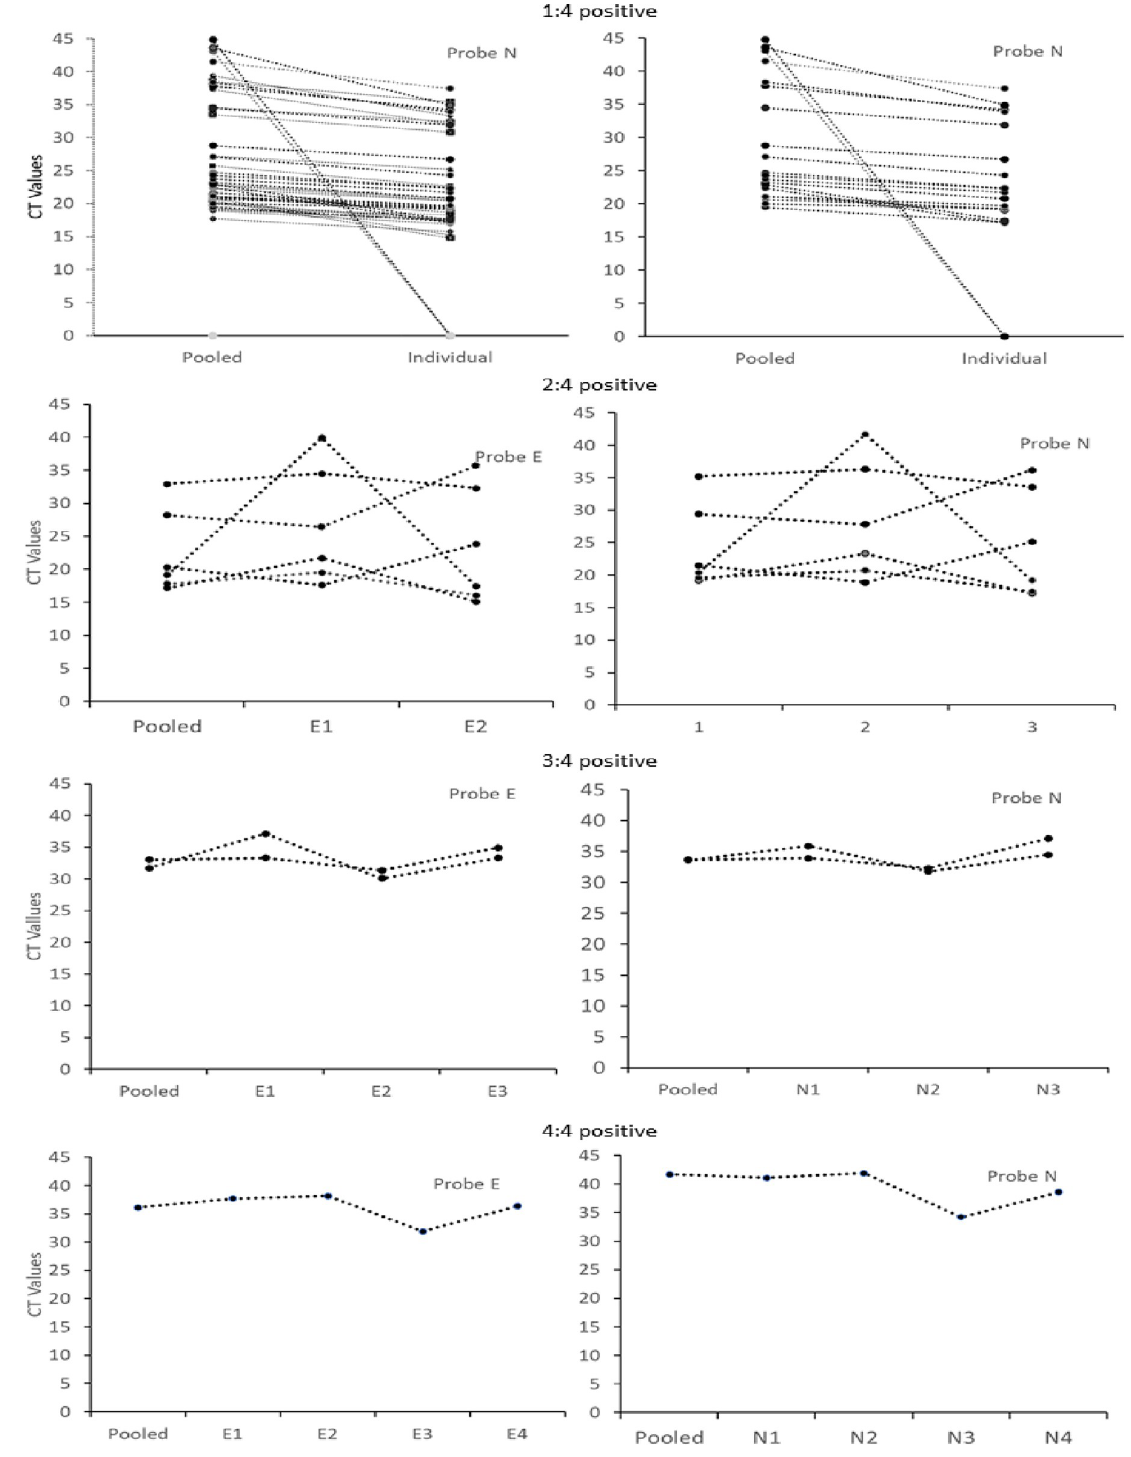
Fig 2. CT values of samples containing 1, 2, 3 and 4 positive samples in a pool.